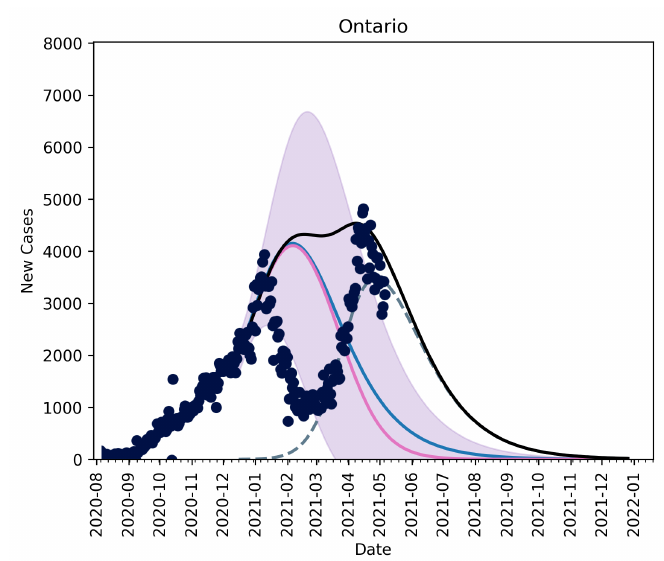
Figure A1. Figure validating model fitting and scenario building. The model is fit to data from 12 December 2020 to 11 January 2021. We augment the data with data from 12 January 2021 until 7 May 2021. We see that the hybrid data and scenario approach properly detected peaks out to four months in advance. Between January and April 2021, Ontario went through multiple phases of lockdown and relaxation of non-pharmaceutical interventions, which the model does not capture (as they were unknowable at the time). The peak detection makes the model a valuable tool for long-term planning. Thee pink line is the continuation of the fit, the blue line is the new wildtype trajectory when the mutant scenario is introduced, and the dashed line is the mutant strain. The black line is the combination of wildtype and mutant. The black line is the total new cases per day, and this is what should be compared to the data as the new cases per day is reported as a total. The shaded region is the 95% confidence interval from the